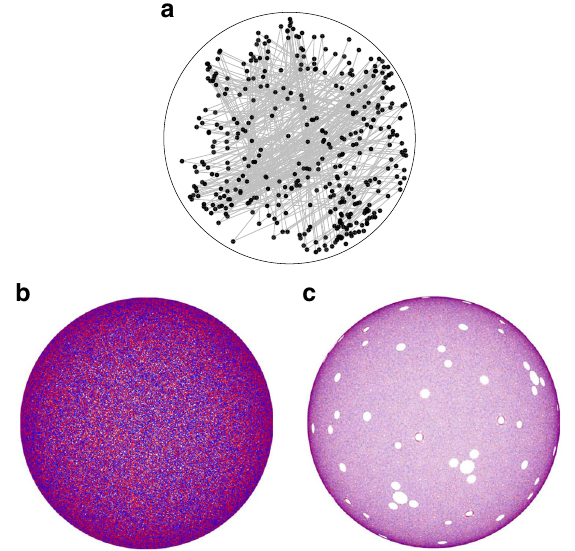
Fig. 5 Mixing under the (75°, 60°) protocol. a Tracer particle positions (black points) and stroboscopic paths (gray lines) in a 500-iteration experiment continuously explore nearly the entire domain with no obvious periodic (non-mixing) regions. b In the corresponding FL model, tracers are mixed throughout the domain, consistent with the experiment. c The PWI model predicts a mostly mixed domain with a few small cells that are indiscernible in the experiment and FL model that manifest as non-mixing regions in the experiment. Instead the PWI model generates large arrowhead-like features consisting of multiple small cells with transport barriers between adjacent red and blue arrowheads. However, the colors and positions of the arrowhead features correspond to the ‘ fi nger ’ features in the experiment and FL model.